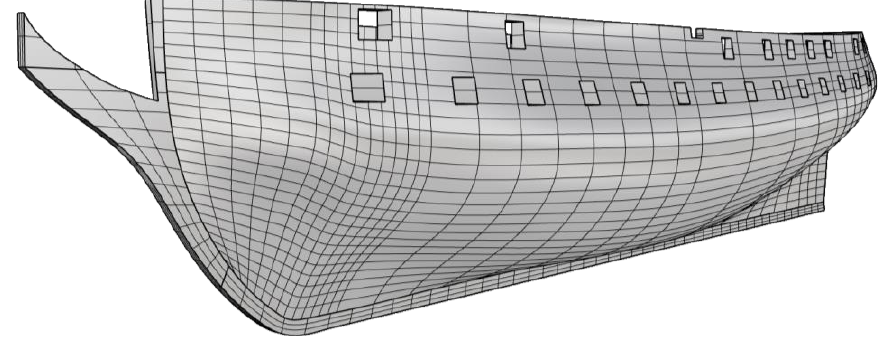
Figure 5 . NURBS surfaces in Rhino3D. Figure 5. NURBS surfaces in